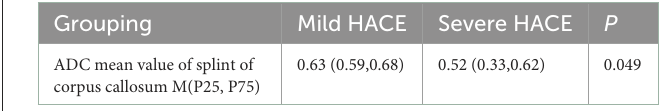
TABLE 8 The ADC mean values of paraventricular and periventricular (splenium of corpus callosum) white matter edema in 30 patients with mild and severe HACE (X10 − 3 mm 2